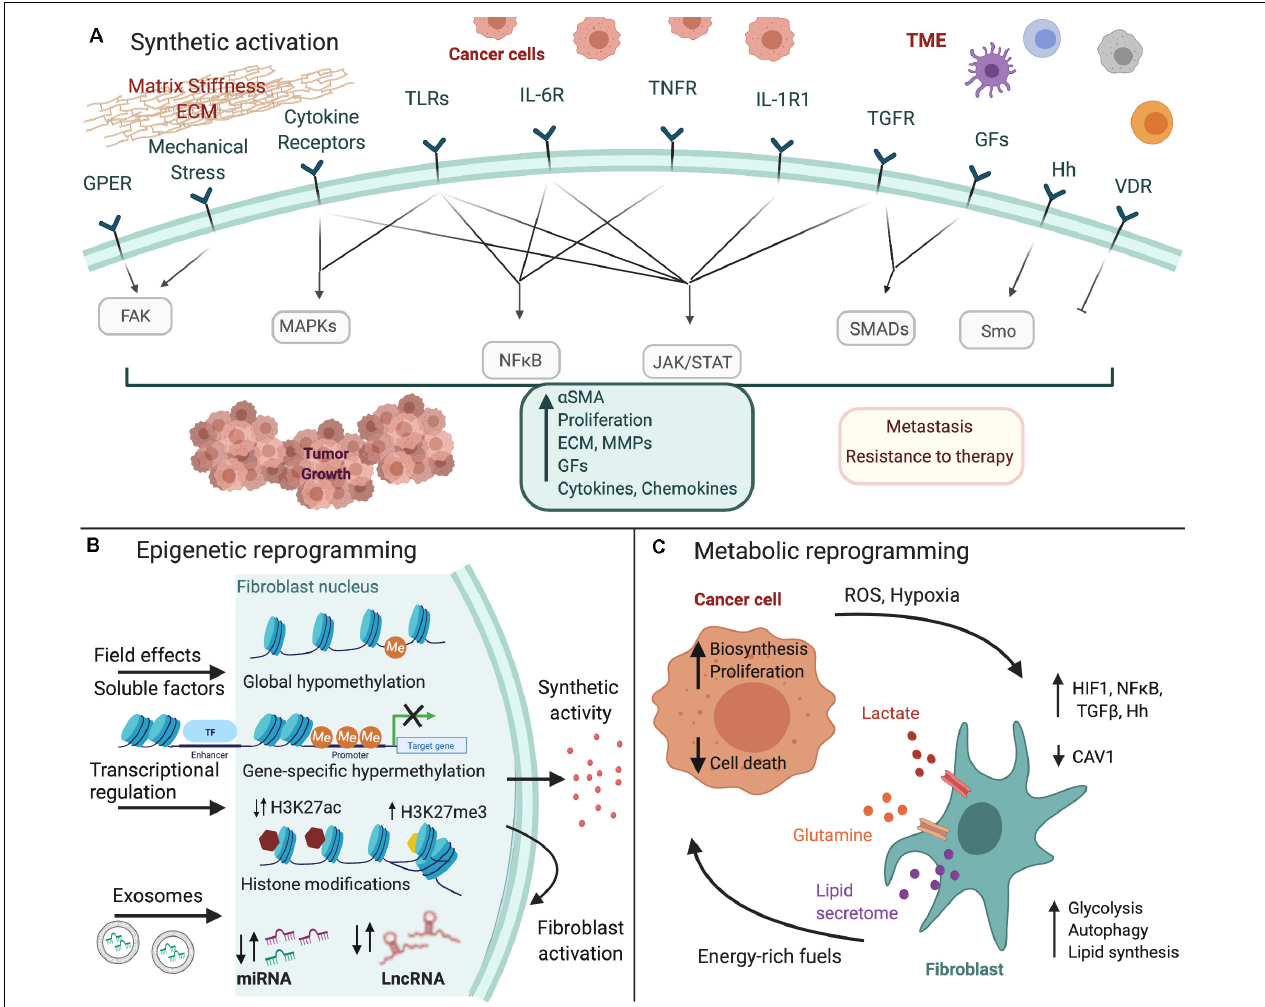
FIGURE 1 | Fibroblast reprogramming in gastrointestinal cancer. Cancer cells and the tumor microenvironment (TME) induce the (A) synthetic activation of fibroblasts to CAFs, as well as their (B) epigenetic and (C) metabolic reprogramming. Major inducing signals and downstream pathways that regulate these processes are shown. The figure was created with